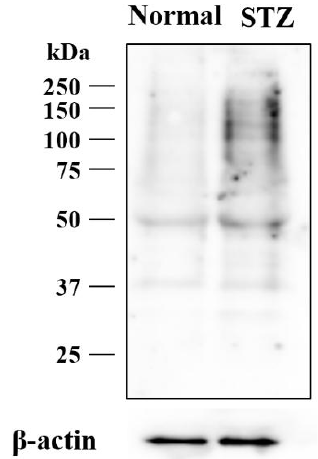
Figure 4. Lumican expression in the cornea of STZ rat. The lumican expression level in the cornea of STZ rats was higher than in that of the normal rats.